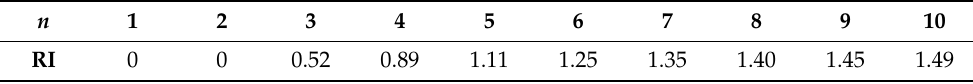
Table 2. Average random consistency index (RI) values [45].